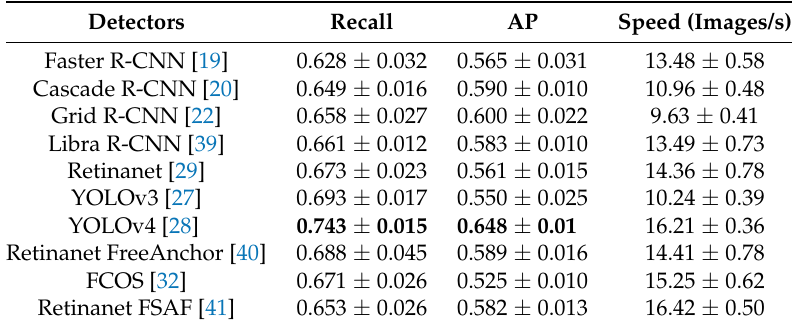
Table 8. Results on mixed resolution EPD-C subset. Train resolution, 1–2 m/pixel; test resolution, 1–2 m/pixel. AP refers to average precision. Recall, AP, and speed are expressed in the format of mean ± standard deviation on the basis of 10 rounds of test